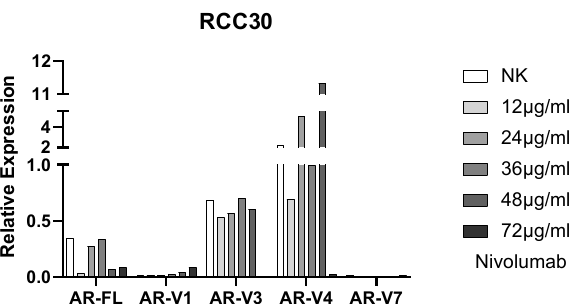
Figure 7. Expression of AR-FL and AR-SVs in RCC30 cells.